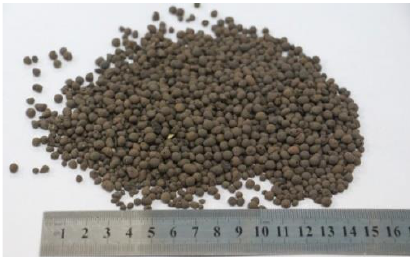
Fig. 1. LWCA particles used in the